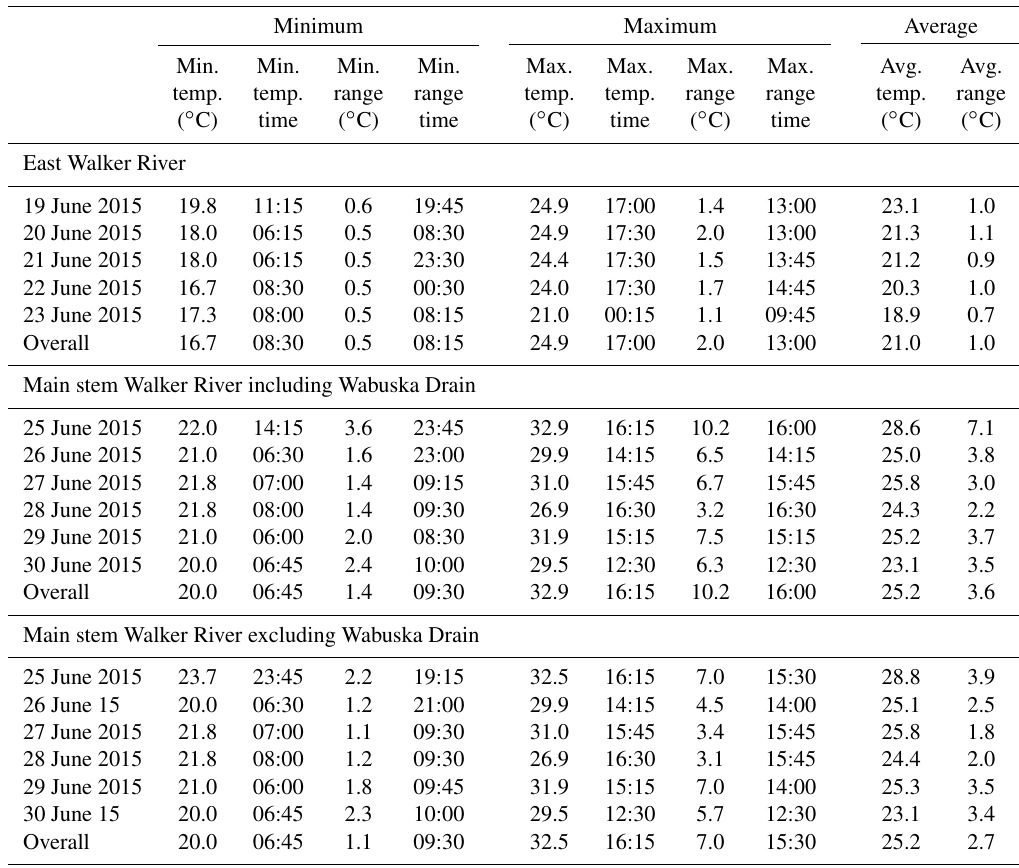
Table 2. Daily stream temperatures and ranges for DTS deployments in the East Walker River (11:15LT on 19 June 2015 to 09:45LT on 23 June 2015) and main stem Walker River (14:15LT on 25 June 2015 to 12:30LT on 30 Jun 2019). Minimum Maximum Average Min. Min. Min. Min. Max. Max. Max. Max. Avg. Avg. temp. temp. range range temp. temp. range range temp. range ( ◦ C) time ( ◦ C) time ( ◦ C) East Walker River